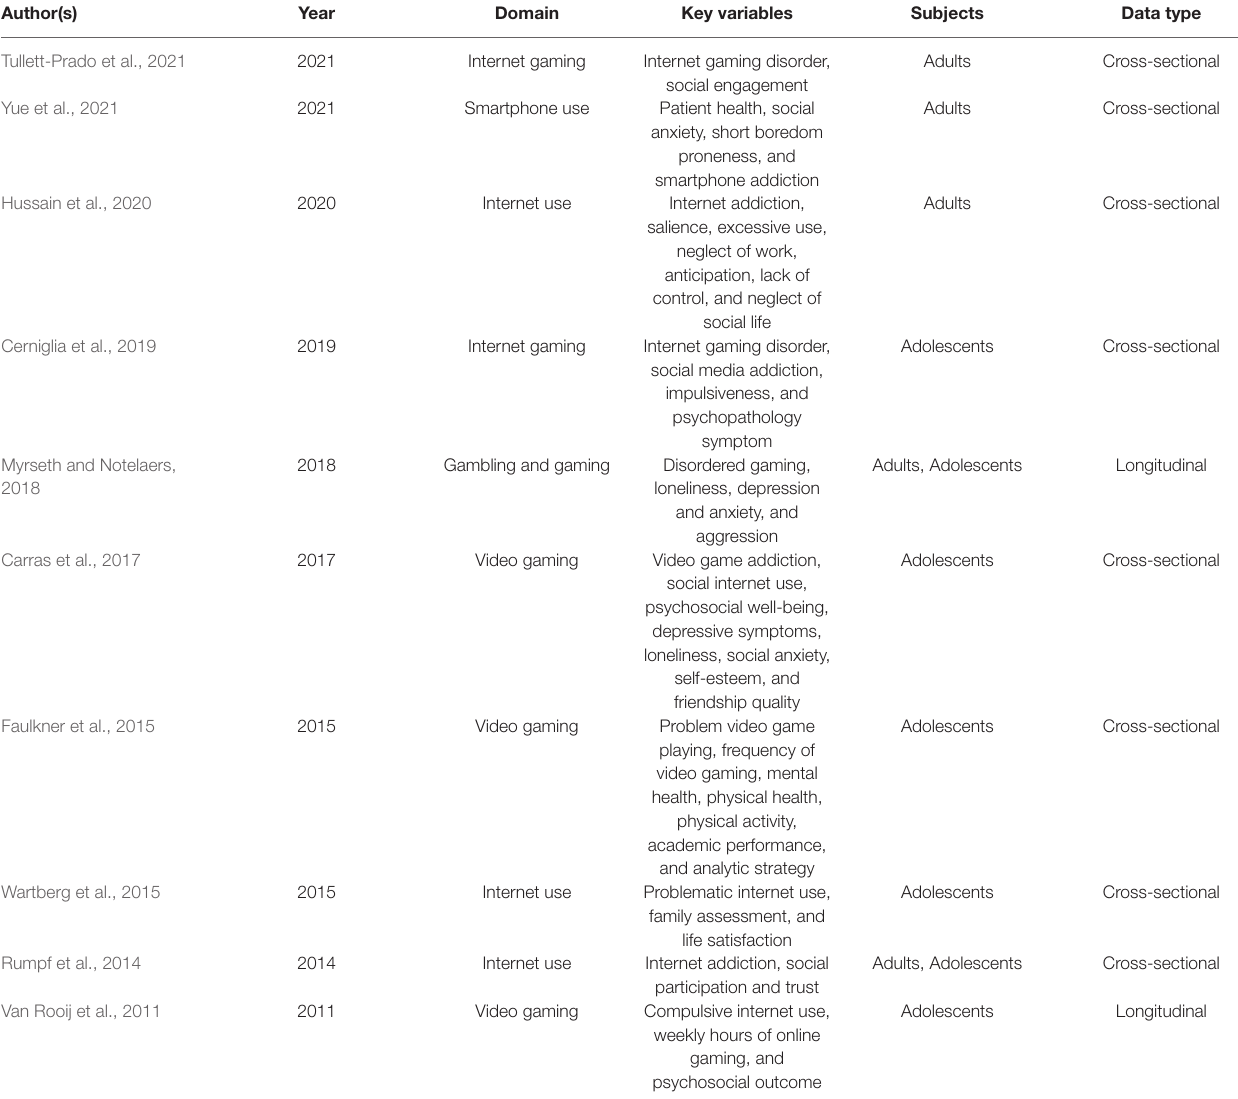
TABLE 1 | Prior research using latent class analysis (LCA) in behavioral